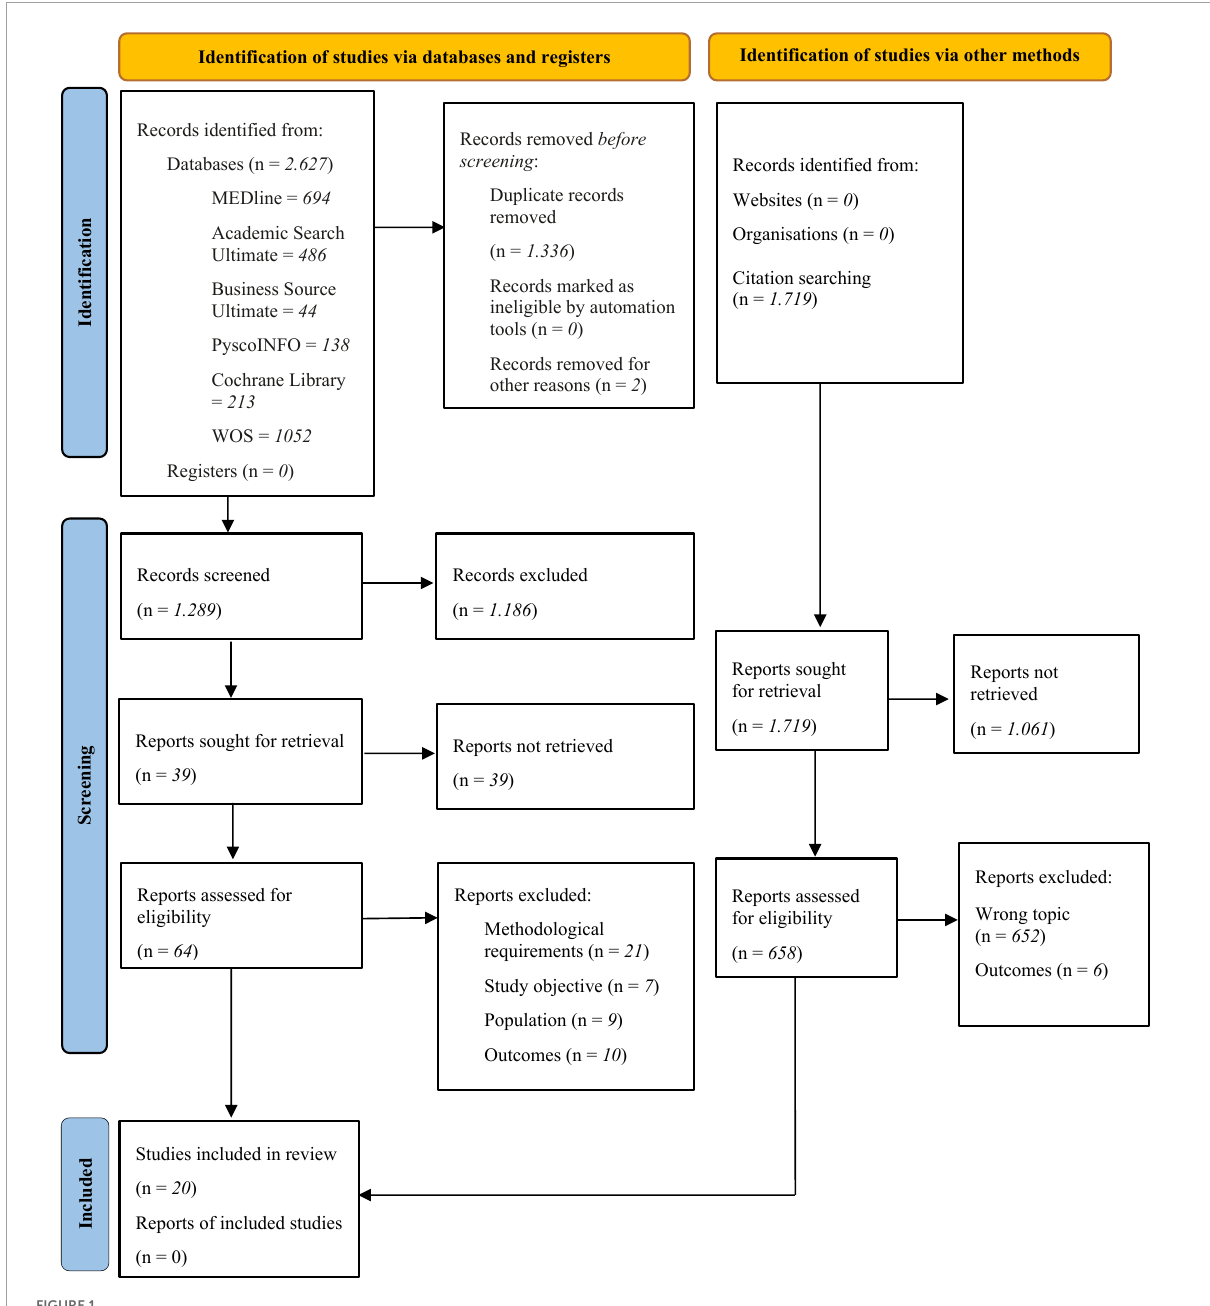
FIGURE1 Preferred reporting items for systematic reviews (PRISMA) flow diagram of the included and excluded studies throughout the systematic review protocol